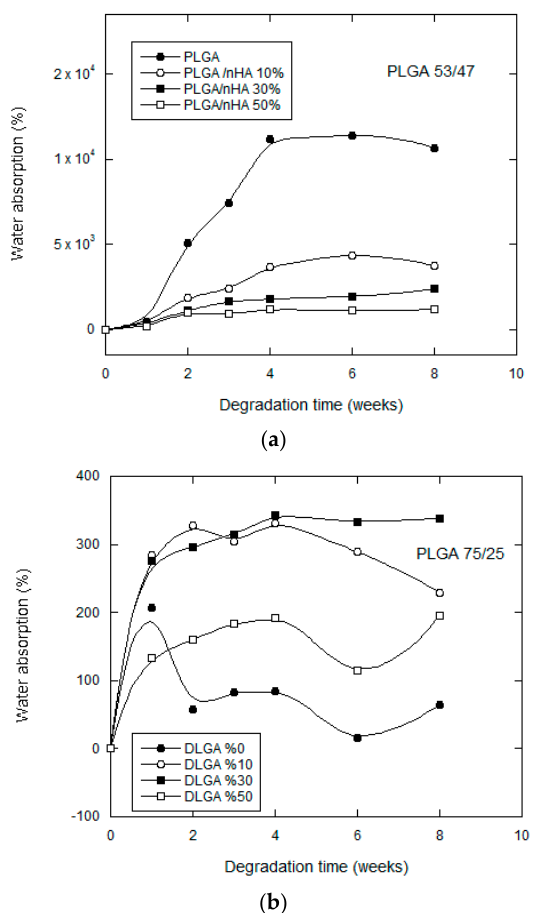
Figure 4. Water absorption for: ( a ) PLGA (53/47)/nHA; and ( b ) PLGA (75/25)/nHA composite scaffolds as a function of degradation time.